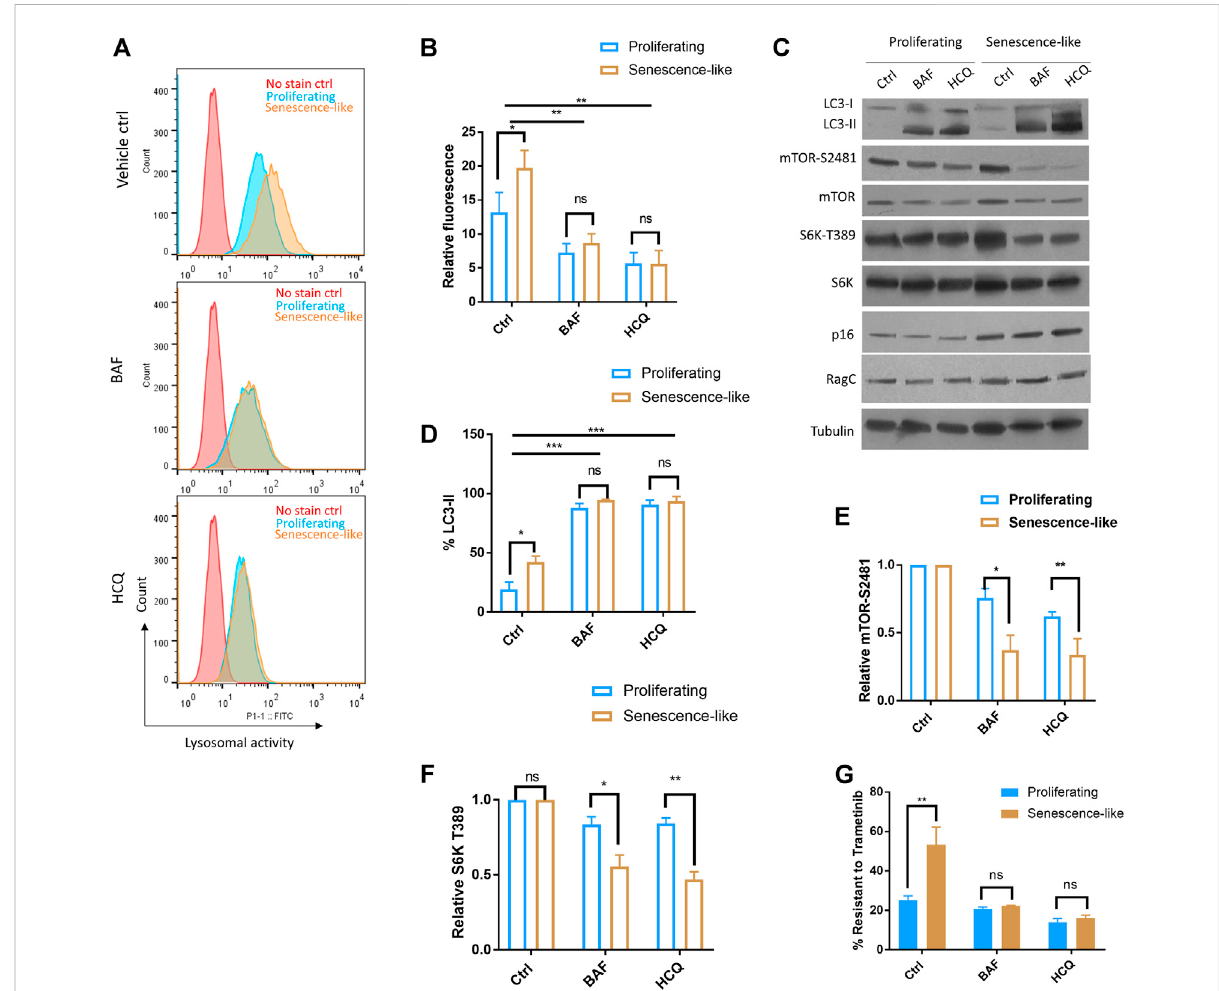
FIGURE 3 Hydroxychloroquine and Ba fi lomycin-A1 reduced mTOR activity and sensitized senescence-like HepG2 cells to a MEK inhibitor. (A) Flow cytometry con fi rmed the inhibition of lysosomal activity by ba fi lomycin A1 (BAF) and hydroxychloroquine (HCQ). Cells treated with 100 nM BAF and 100 uM HCQ for 3 h were stained with a self-quenched fl uorescent substrate from Lysosomal Intracellular Activity Assay Kit (Abcam). Senescence- like HepG2 cells showed elevated lysosomal activity. No stained controls were used as references. Shown are representative data. (B) Quanti fi cation of three experimental data shown in (A) . Student ’ s t test p < 0.05(*), 0.01(**), not signi fi cant (ns). (C) HCQ and BAF reduced mTOR activity in senescence-like but not proliferating HepG2 cells. Cells were treated with 100 nM BAF and 100 uM HCQ for 3 h and indicated proteins were examined by Western blotting. Accumulation of LC3-II indicated the lack of lysosomal degradation. Shown are representative data. (D) Quanti fi cation of LC3-II accumulation in N = 3 experiments. Accumulation of LC3-II indicated the lack of lysosomal degradation. Student ’ s t test p < 0.05(*), 0.001(***), not signi fi cant (ns). (E) Quanti fi cation of mTOR activity by mTOR-S2481 phosphorylation. Blots were quanti fi ed by ImageJ and normalized to control (100%). N = 3 experiments were tested by Student ’ s t test p < 0.05(*), 0.01(**), not signi fi cant (ns). (F) Quanti fi cation of mTOR activity by S6K-T389 phosphorylation. Blots were quanti fi ed by ImageJ and normalized to control (100%). N = 3 experiments were tested by Student ’ s t test p < 0.05(*), 0.01(**), not signi fi cant (ns). (G) BAF and HCQ treatment sensitize senescence-like HepG2 cells to MEK inhibitor Trametinib. Cells were treated with 10 nM Trametinib and100 nM BAF or 100 uM HCQ for 3 days and survival were examined by CellTiter-glo. Data were normalized to untreated controls for each experiment. N = 3 experiments were plotted and analyzed by Student ’ s t test p < 0.01(**), ns, not signi fi